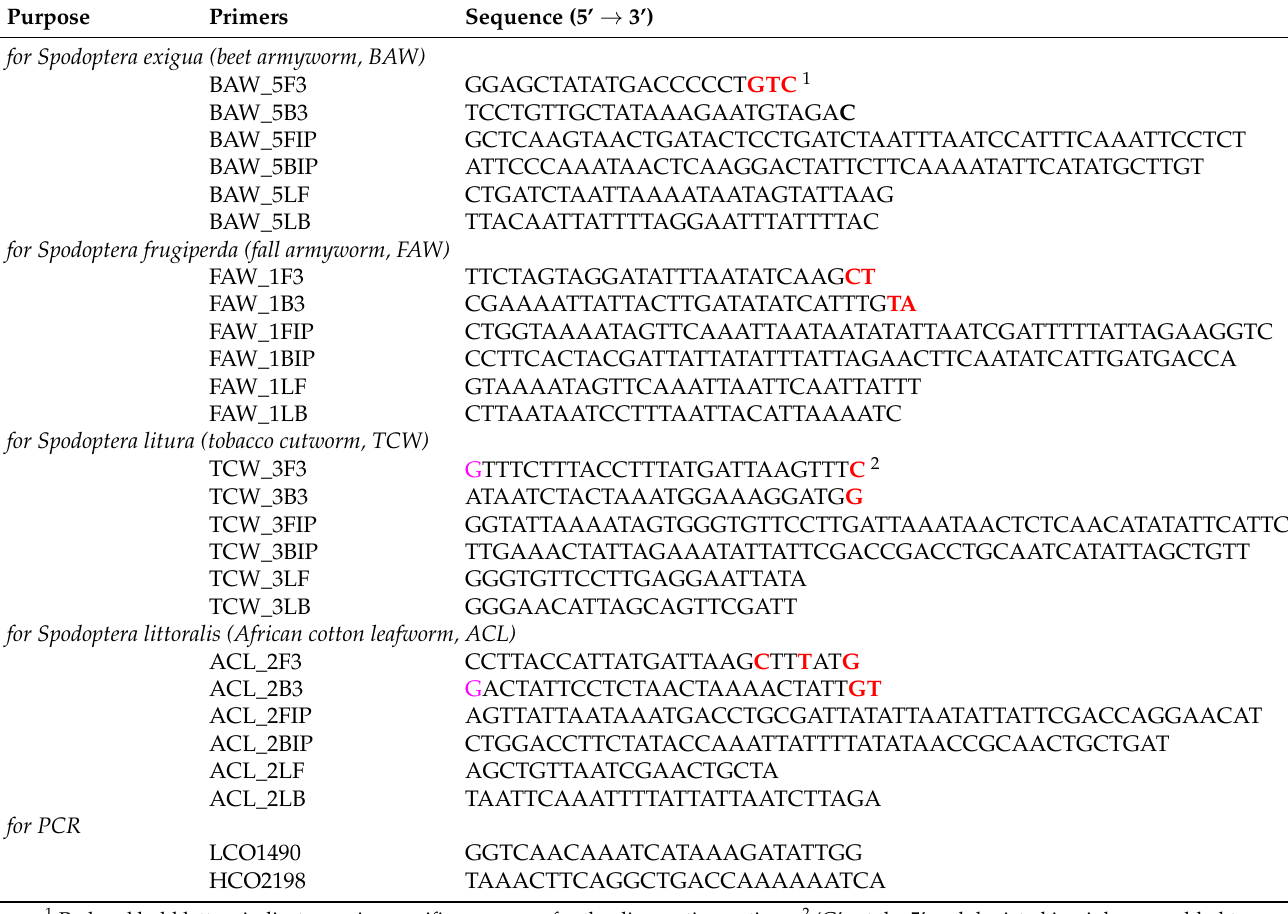
Table 1. Primers used for species diagnostic LAMP and PCR in this